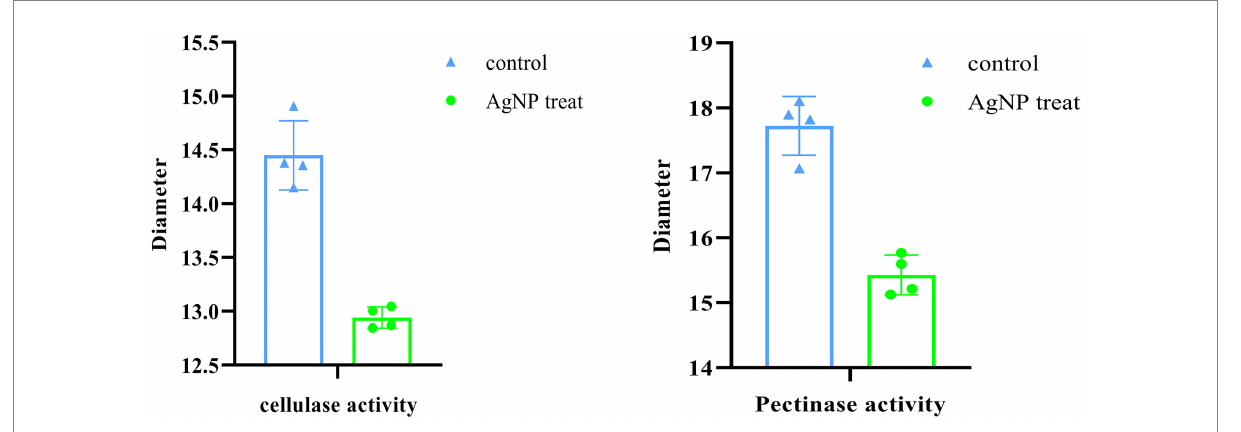
FIGURE 10 Inhibition of extracellular pectinase and cellulase activities.